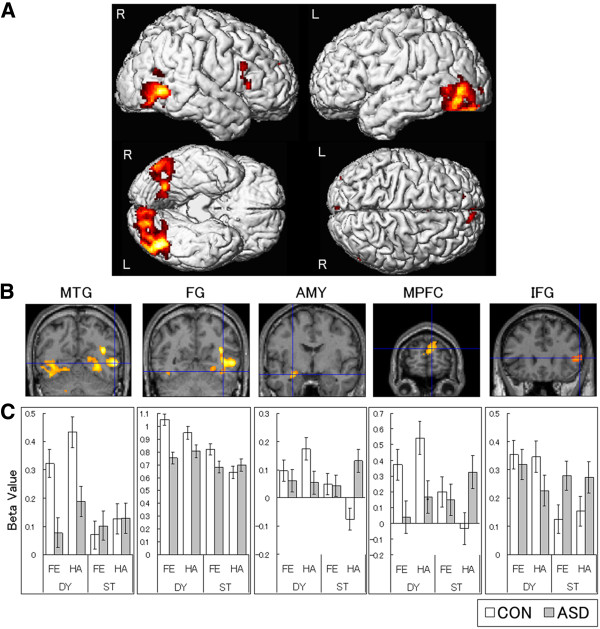
Brain activation for the significant interaction between group and presentation condition. Weaker activation was found in the autism spectrum disorders (ASD) group than in the control (CON) group for dynamic (DY) versus static (ST) expressions. A. Statistical parametric maps rendered on spatially normalized brains. A height threshold of p < .01 (uncorrected) was used without extent threshold restriction for display purposes. L = Left hemisphere; R = Right hemisphere. B. Statistical parametric maps of representative brain regions overlaid on the normalized anatomical MRI of one of the participants in this study. From left to right, the activation of the middle temporal gyrus (MTG; x 52, y -62, z 0; t = 5.08), fusiform gyrus (FG; x 40, y -58, z -14; t = 3.00), amygdala (AMY; x -28, y -4, z -18; t = 2.89), medial prefrontal cortex (MPFC; x 8, y 66, z 20; t = 3.87), and inferior frontal gyrus (IFG; x 48, y 26, z 8; t = 3.06) is shown. The statistical thresholds are the same as above. C. Mean parameter estimates (± SE) of brain regions corresponding to the above overlaid MRIs. The data were extracted at the sites of peaks. FE = Fear; HA = Happiness.